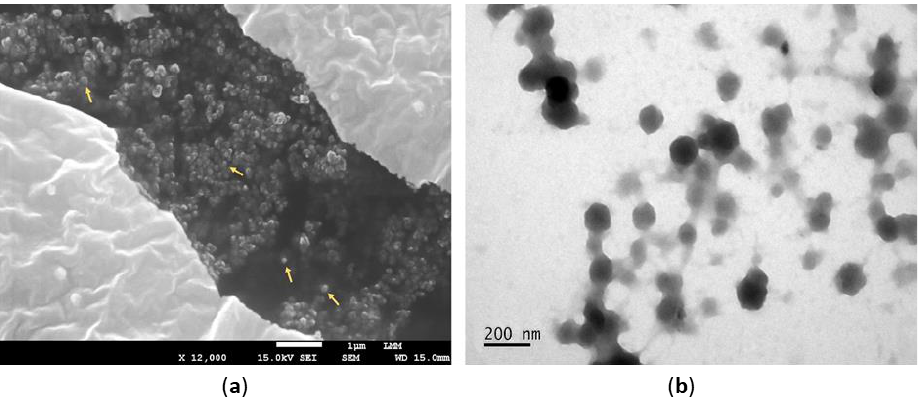
Figure 2. Representative ultramicrographs of pequi oil-based nanoemulsions (PeNE), acquired via ( a ) scanning and ( b ) transmission electron microscopy. Yellow arrows indicate PeNE nanodroplets in panel ( a ).